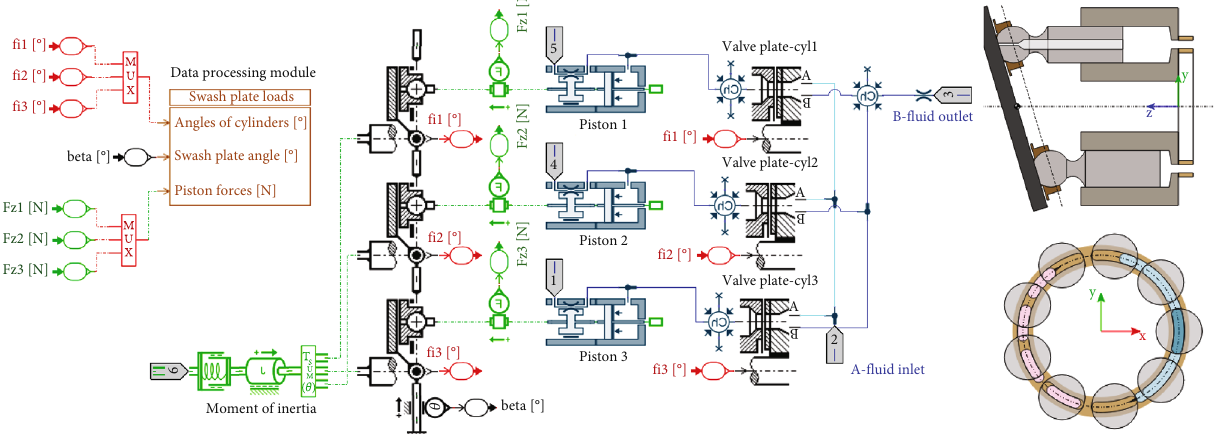
Figure 6: The LOX three-row piston pump model (left) and kerosene piston pump (right). Table 6: Partial model parameters for pump simulation. Parameters